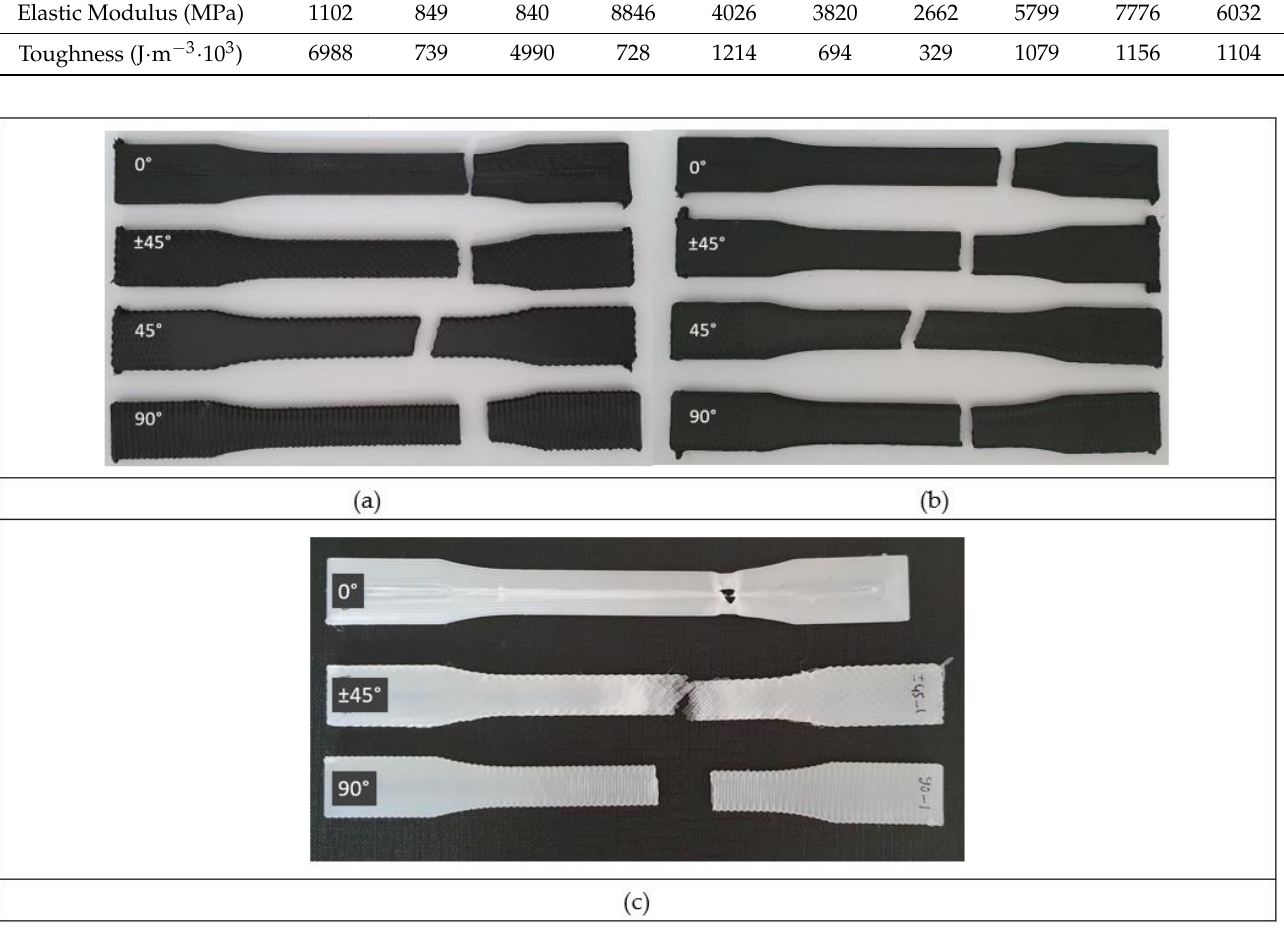
Figure 4. Tensile test fracture patterns. ( a ) PA – CF without a frame ( b ). PA – CF with a frame. ( c ) PA without a